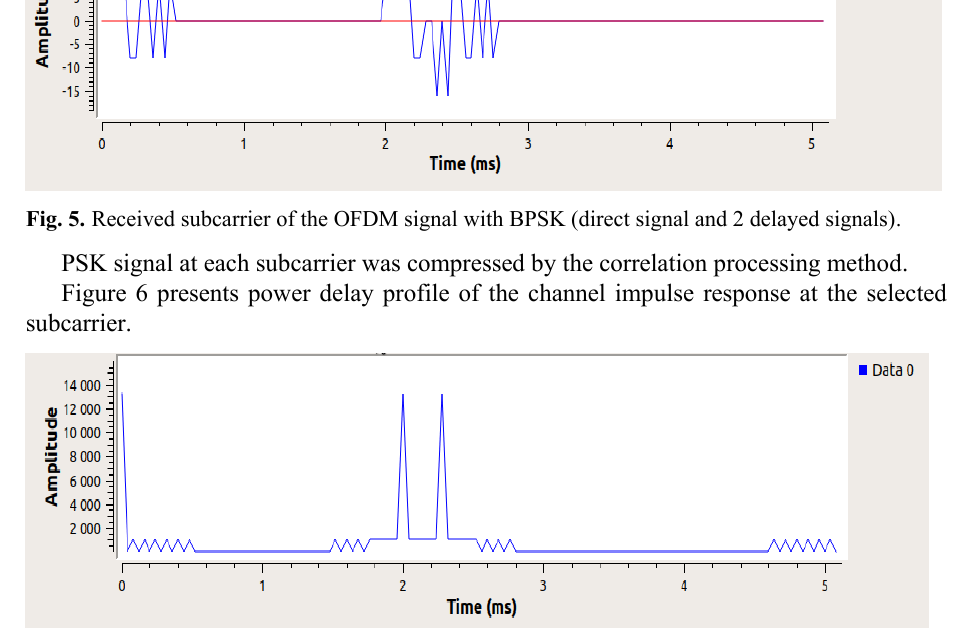
Fig. 6 . PDP of the channel impulse response at the subcarrier.